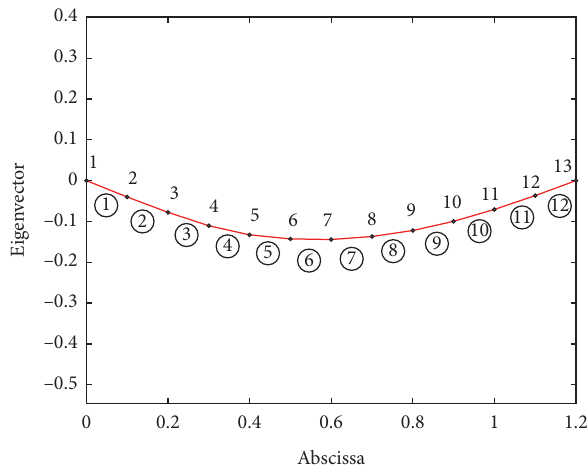
Figure 2: The measured first modal eigenvector.